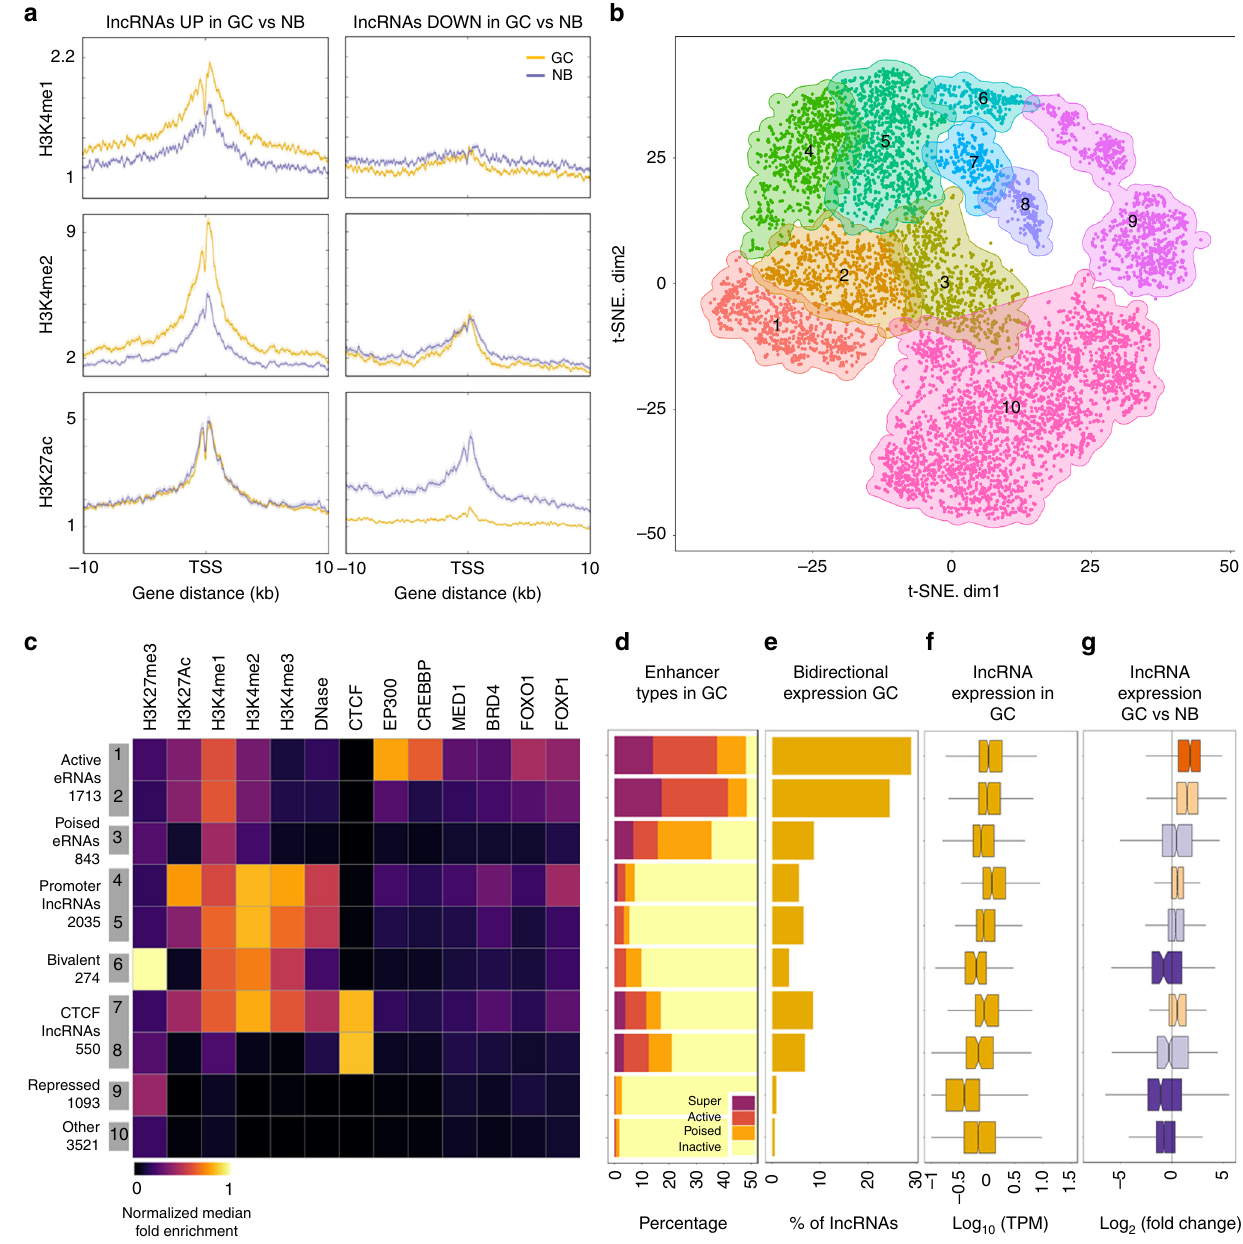
Fig. 5 Categorization of long non-coding RNAs (lncRNAs). a Density plot of chromatin immunoprecipitation-sequencing (ChIP-seq) levels of H3K4me1, H3K4me2, and H3K27ac in lncRNAs differentially expressed between naive B (NB) cells and germinal center (GC) B cells. b t -distributed stochastic neighbor embedding ( t -SNE) plot showing 10 different clusters of lncRNAs expressed in GCs and their association with ChIP-seq levels of H3K4me1, H3K4me2, H3K4me3, H3K27ac, H3K27me3, DNase, CTCF, EP300, CREBBP, MED1, BRD4, FOXO1, and FOXP1. c Heatmap of median of